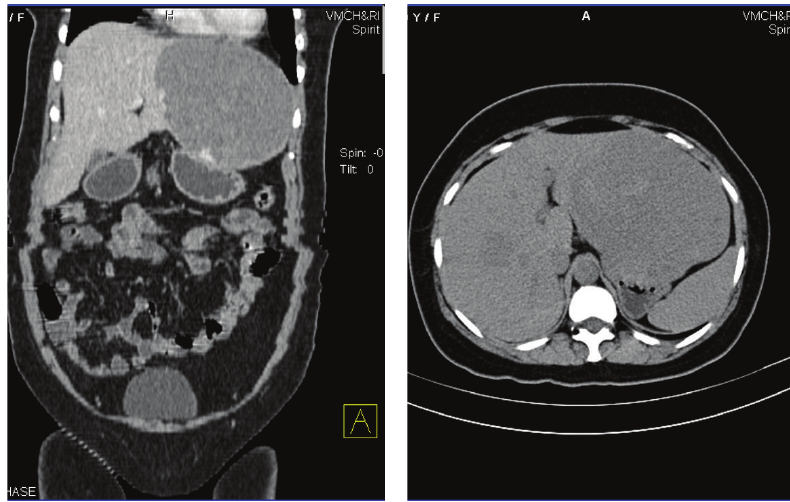
Figure 1: CECT showing multiple hemangioma.